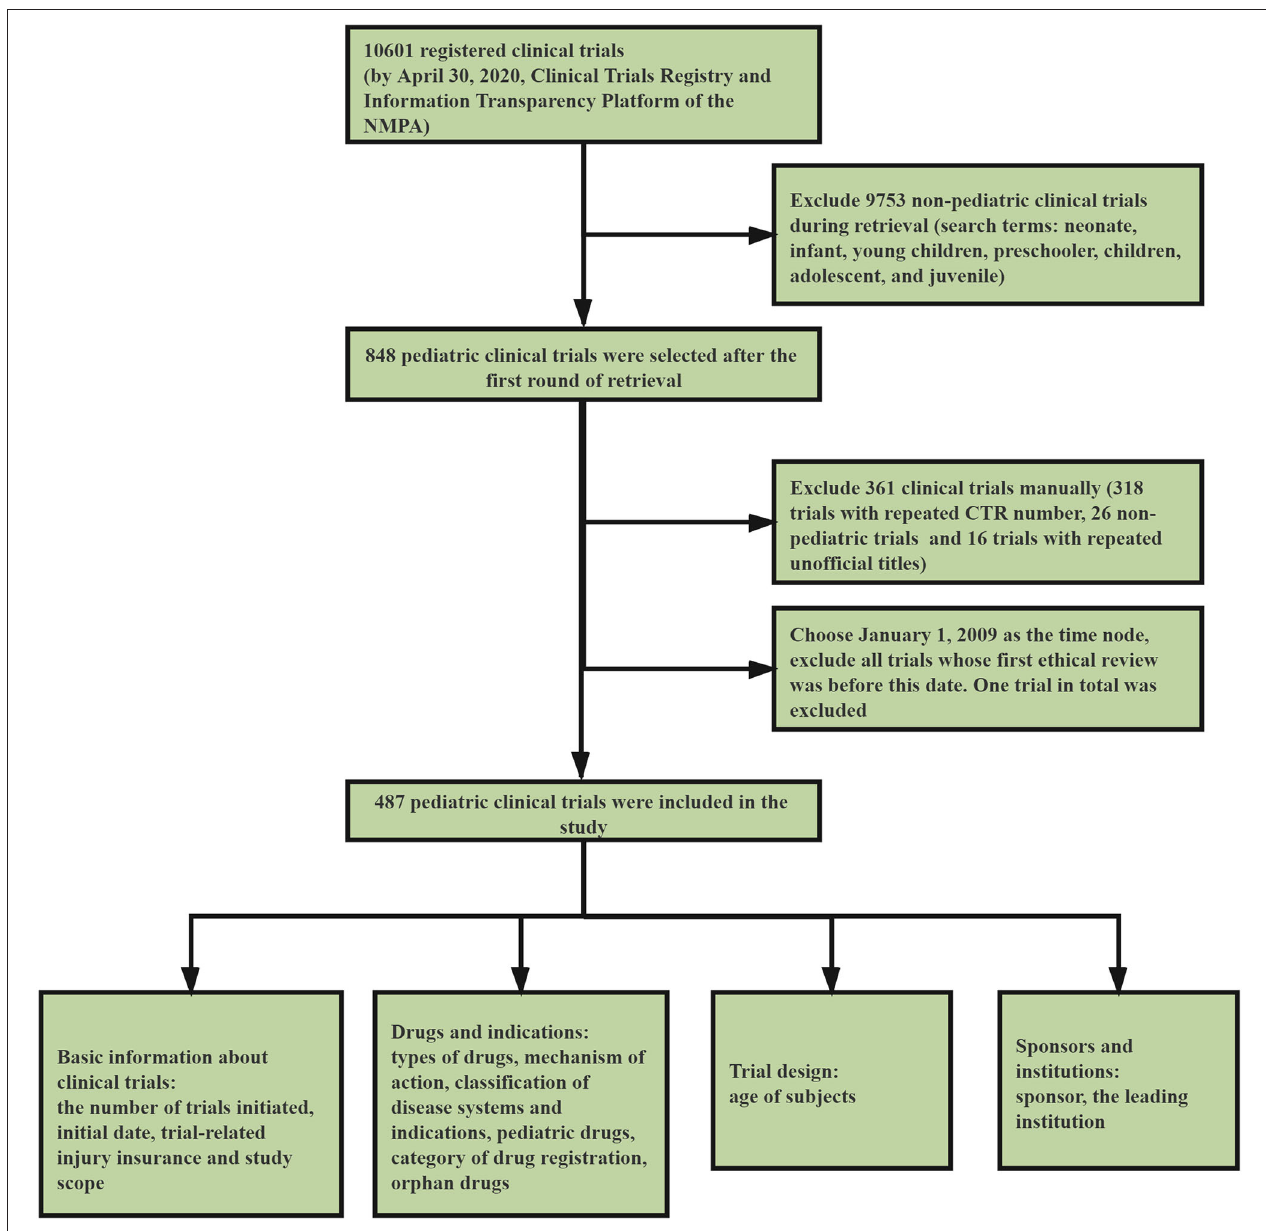
FIGURE 1 | Strategy of retrieval and selection of pediatric clinical trials.